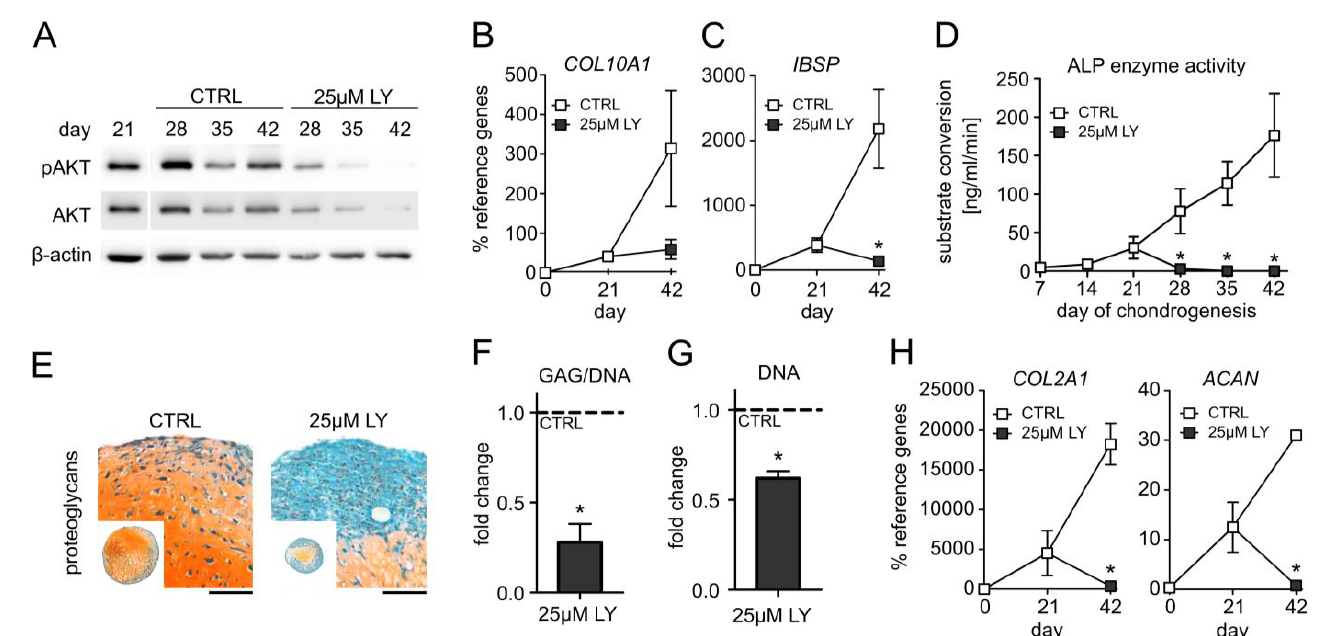
Figure 3. AKT suppression impairs chondrogenesis of MSCs. MSC pellets were subjected to chon- drogenic culture for 6 weeks and treated with 25 µ M LY294002 (LY) or 0.1% DMSO solvent (CTRL) starting from day 21 of chondrogenesis. Samples were harvested at indicated time points. ( A ) Western blot analysis for pAKT and AKT using β -actin as loading control. Shown is one representative of three independent experiments. All samples were loaded on the same gel and detected on the same membrane. ( B , C ) Gene expression analysis by qPCR for COL10A1 and IBSP at days 0, 21, and 42 using CPSF6 and RPL13 as reference genes. ( D ) Alkaline phosphatase (ALP) activity was determined in culture supernatants pooled from four pellets per group and time point. ( E ) Paraffin sections of MSC pellets at day 42 were stained for proteoglycans with Safranin O/Fast Green or for type II collagen by immunohistochemistry. Scale bars: 100 µ m for enlarged sections and 1 mm for overviews. Shown is one representative of three independent experiments. ( F ) GAG content at day 42 was assessed by DMMB assay and referred to DNA quantity. ( G ) DNA amount per pellet at day 42 was quantified by Pico Green assay. ( H ) Gene expression analysis of COL2A1 and ACAN by qPCR at days 0, 21, and 42 using CPSF6 and RPL13 as reference genes. Experiments were performed in three independent MSC donor populations (n = 3). Graphs show means ± SEM. * p ≤ 0.05 compared to CTRL at the same time point, MWU.